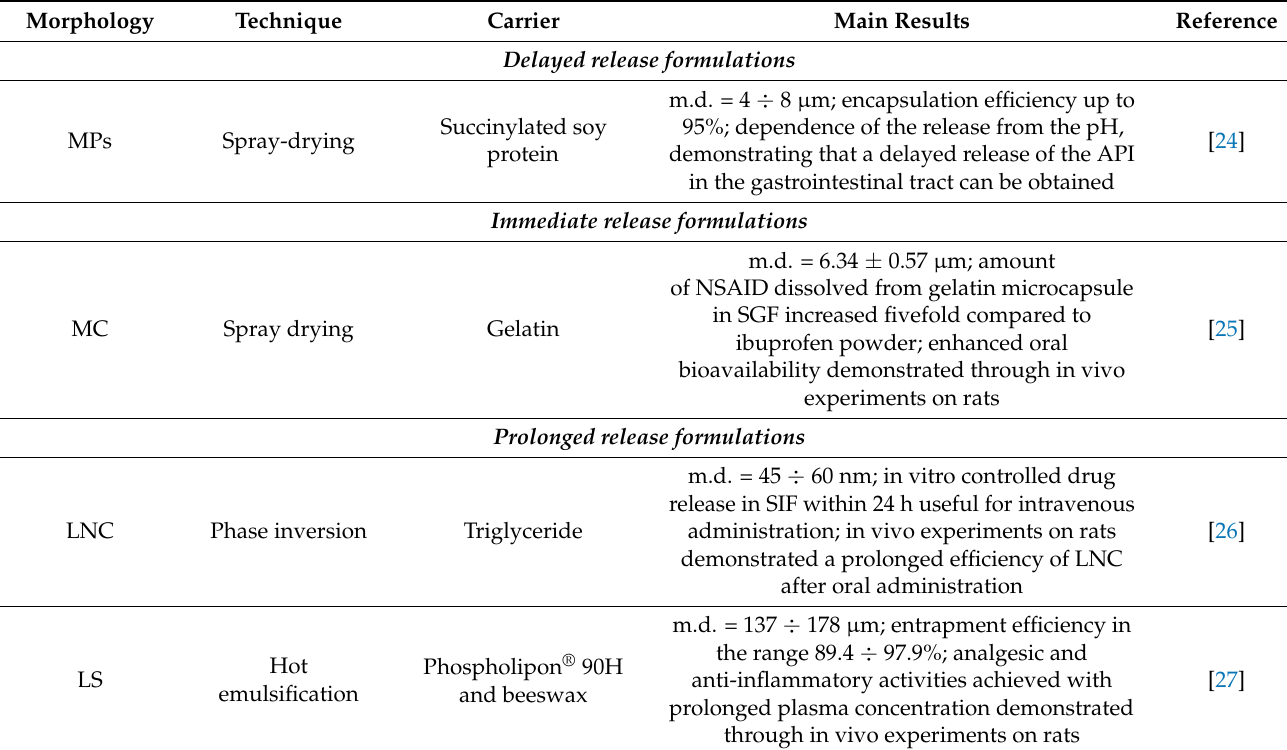
Table 1. Ibuprofen processing. HPH = high pressure homogenization; HSH = high speed homoge- nization; LNC = lipid nanocapsules; LS = lipospheres; MC = microcapsules; m.d. = mean diameter; MH = mucoadhesive hydrogels; MPs = microparticles; MT = mucoadhesive tablets; NLC = nanostruc- tured lipid carriers; NPs = nanoparticles; poly(mPEGMA- co -MAA) = methoxy poly(ethylene glycol) methacrylate- co -poly(methylacrylic acid) copolymer; SGF = simulated gastric fluid; SIF = simulated intestinal fluid; SSS = simulated saliva